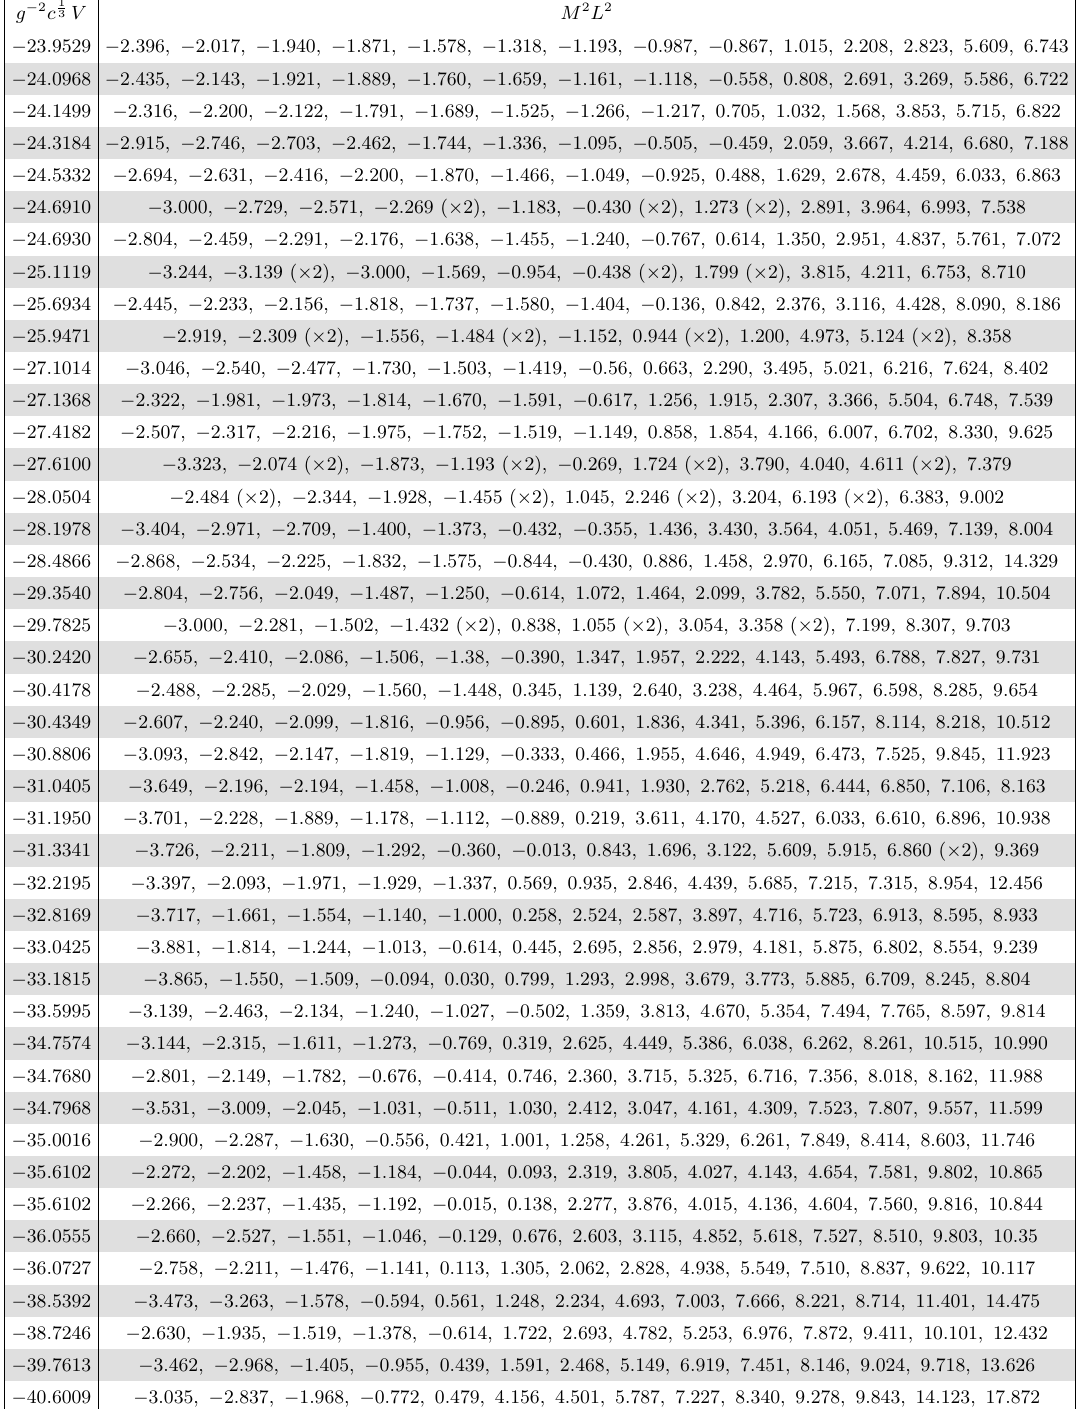
Table 2. Scalar masses within the seven-chiral model for the 43 new non-supersymmetric AdS 4 vacua found in this paper, labelled by the value of the potential. All of them present BF instabilities.